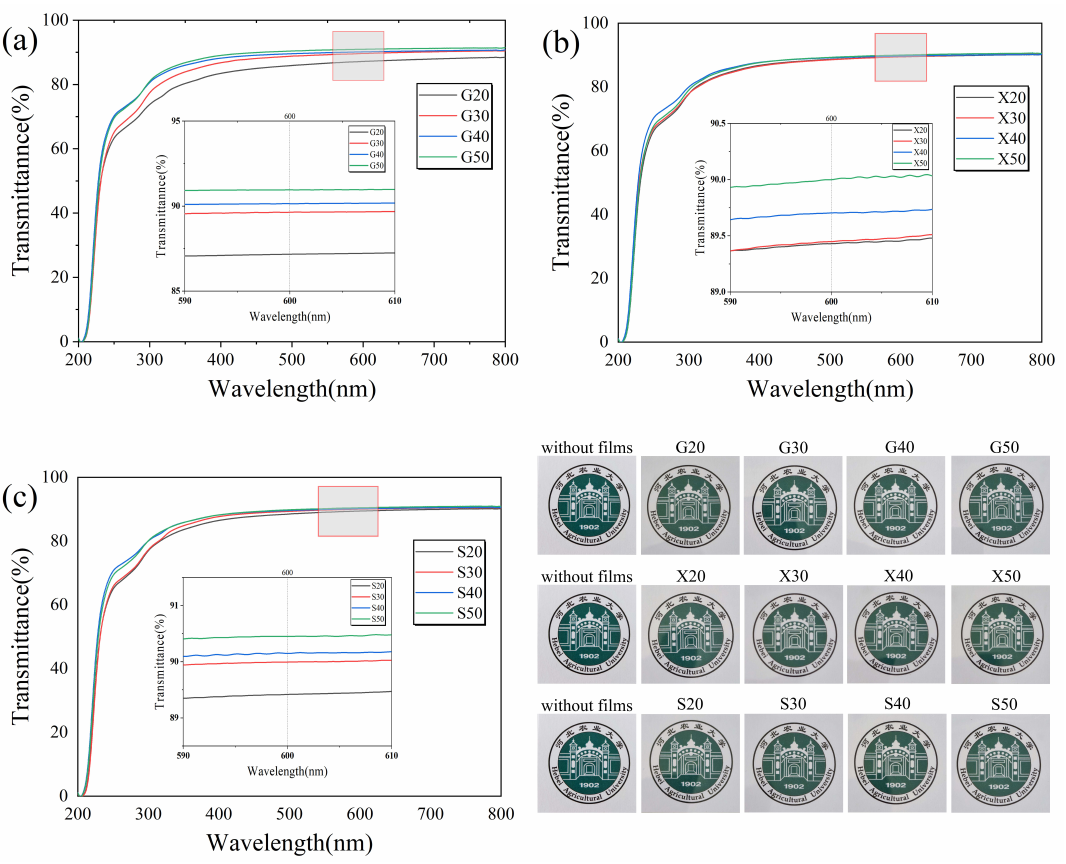
Figure 9. Effects of G ( a ), X ( b ) and S ( c ) addition on light transmission property of the funoran films. The Chinese in the figure refer to Hebei Agricultural